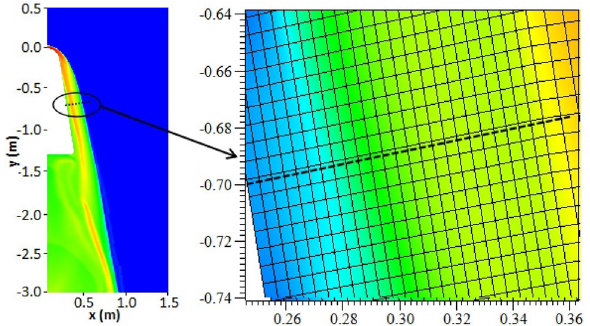
Figure 3. An enlarged schematic diagram of the plasma sheath near the antenna.